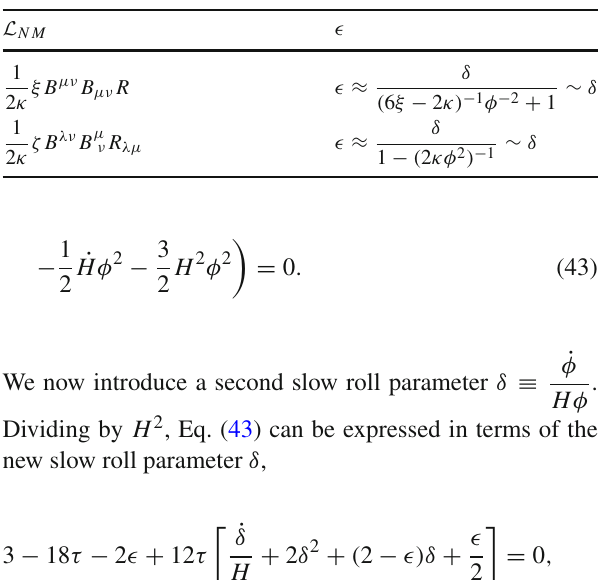
Table 2 Relation between the slow-roll parameters (cid:11) and δ for each case of nonminimal